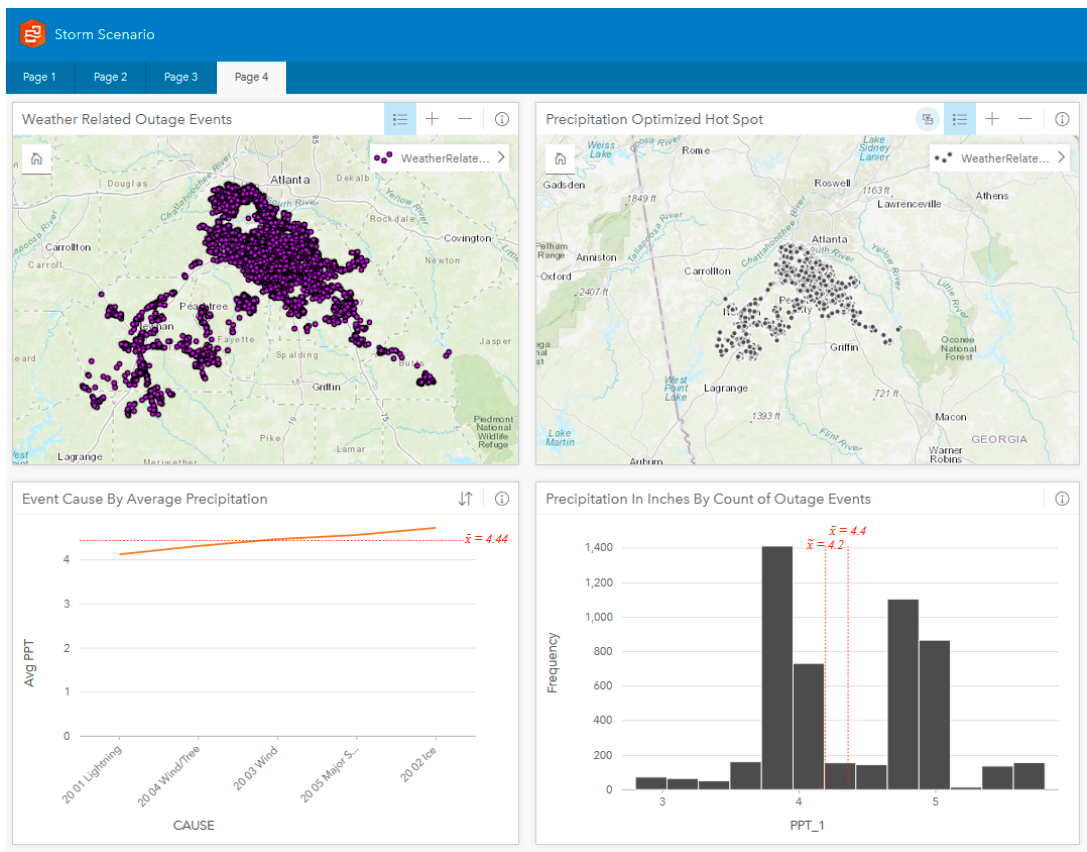
Figure 5. Challenge 1—Storm Scenario Workbook – Page 3.